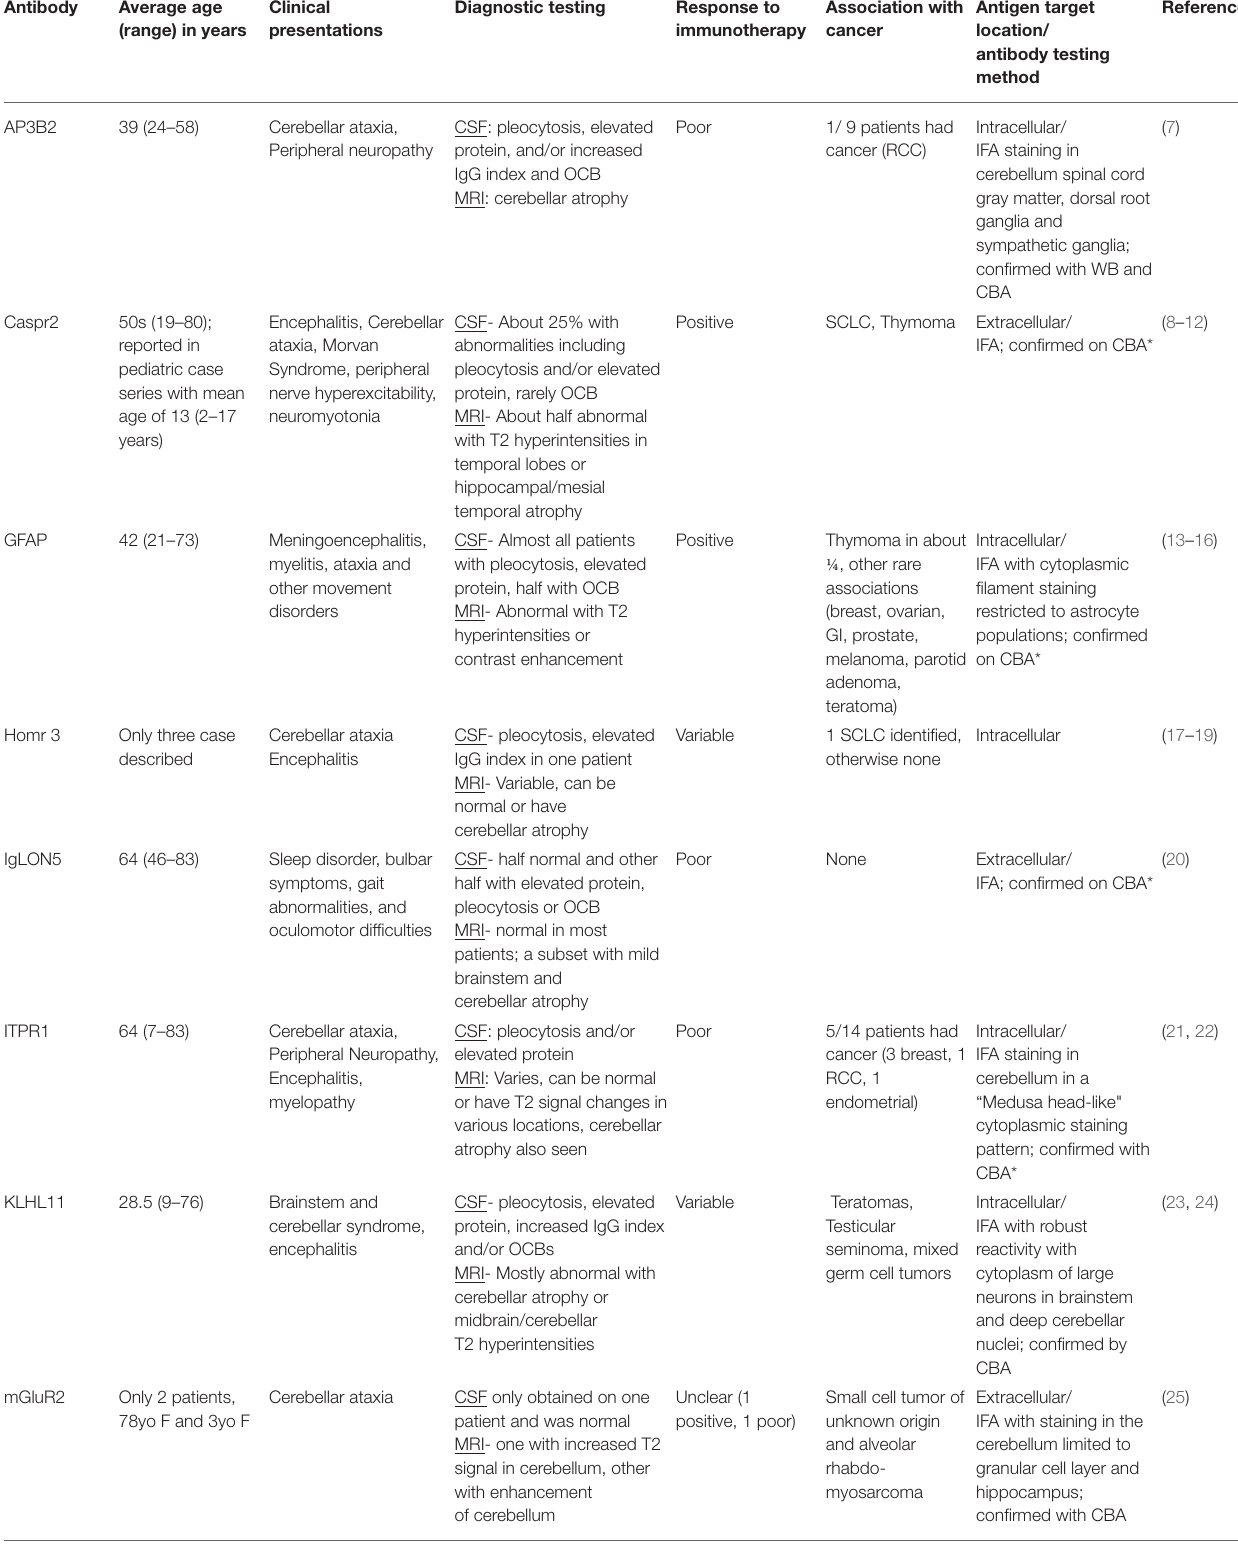
TABLE 2 | Summary table of autoantibodies against neuronal targets identified in syndromes of cerebellar ataxia. Antibody Average age Clinical (range) in years